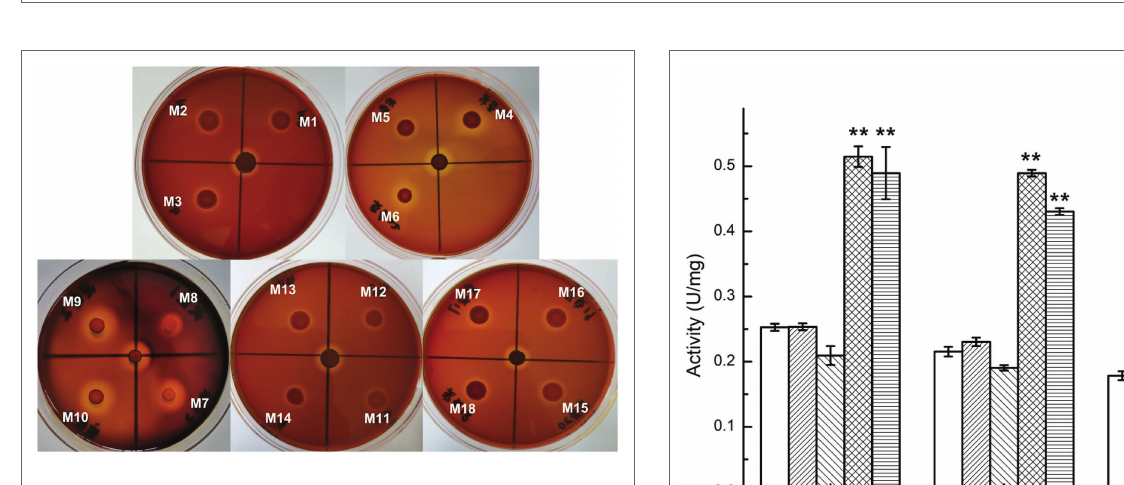
FIGURE 8 | Plate-active results of different mutations. M1–M18 correspond to mutations listed in Table 1 .